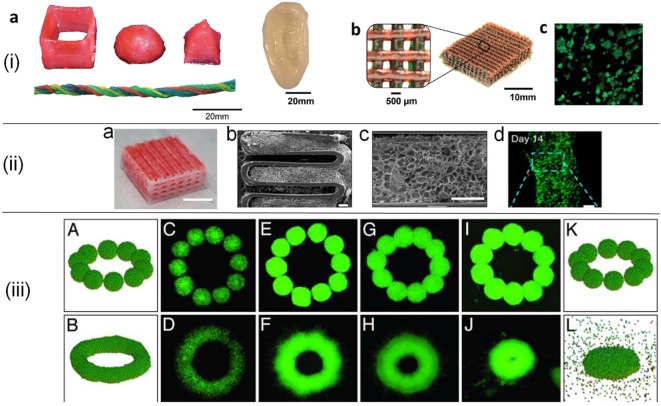
(i) 3D printed constructs in various forms (a,b) using poly(ethylene glycol)–alginate–nanoclay hydrogels. Red food dye was incorporated into some of the bioink formulations for visibility. Live/dead assay of cells (c) in a collagen infused mesh from (b). Reprinted with permission from Hong et al. (2015). Copyright 2015, John Wiley and Sons. (ii) Tissue construct printed from decellularized extracellular matrix (dECM) (a), SEM images of hybrid constructs from dECM supported with polycaprolactone framework (b,c), and fluorescent images of cells (d). Scale bars are 5 mm for (a), 400 µm for (b,c), and 100 µm for (d). Adapted with permission from Pati et al. (2014). Copyright 2014, Nature Publishing Group. (iii) Cell aggregate (500-µm average diameter) configurations in simulations (A,B,K,L) and experiments. C–J correspond to cell aggregates embedded in a neurogel with RGD fragments (C,D) and collagen gels of concentration 1.0 mg/ml (E,F), 1.2 mg/ml (G,H), and 1.7 mg/ml (I,J). Figure adapted with permission from Jakab et al. (2004). Copyright 2004, National Academy of Sciences.